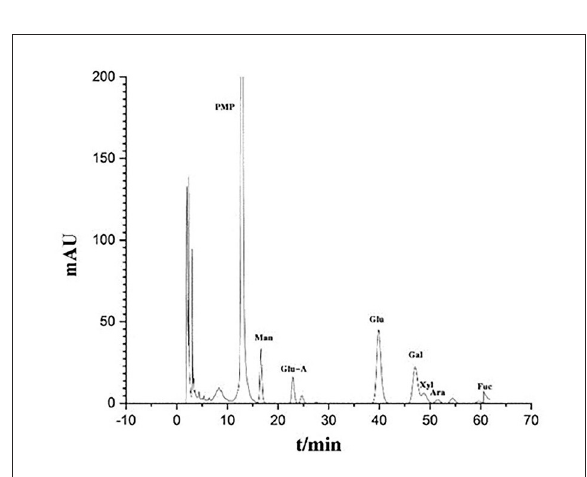
FIGURE2 Monosaccharide and uronic acid composition of IOP as determined by